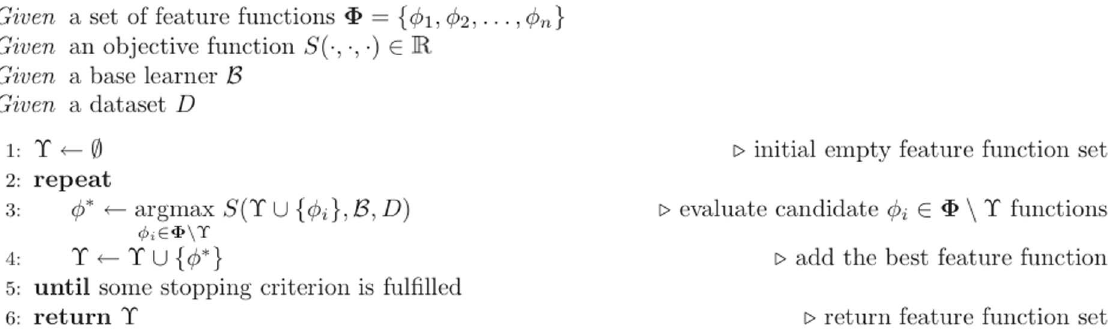
Figure 3. Forward feature function selection algorithm. In order to identify the relevant feature function set, the algorithm requires four components: a dataset, a list of candidate feature functions, a base learner and a criterion to optimize.